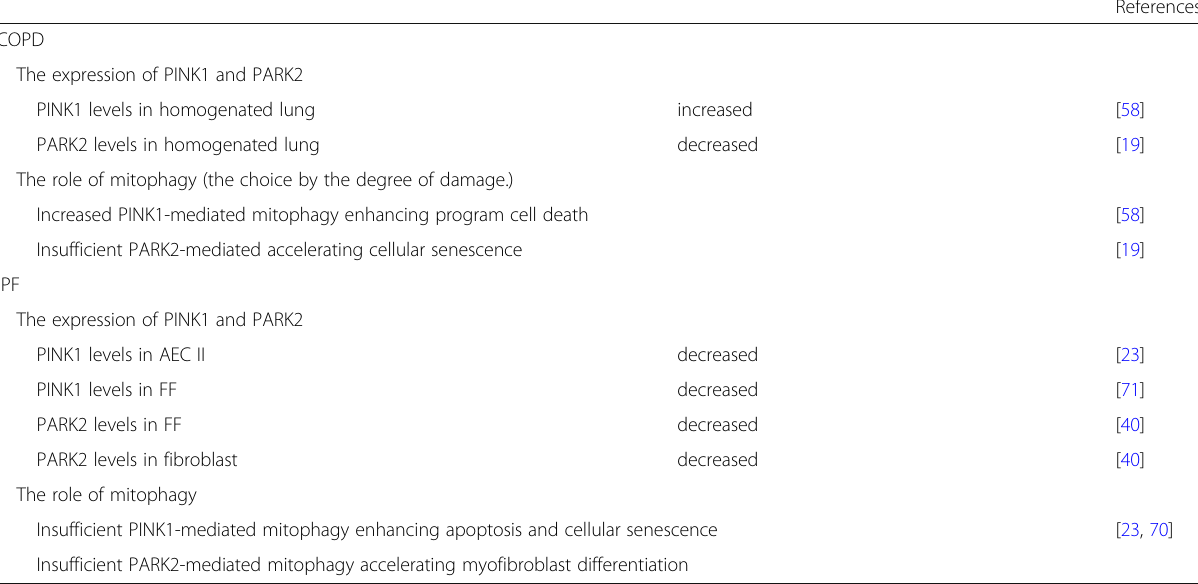
The role of mitophagy Insufficient PINK1-mediated mitophagy enhancing apoptosis and cellular senescence Insufficient PARK2-mediated mitophagy accelerating myofibroblast differentiation AEC II: type II alveolar epithelial cells FF: fibroblast